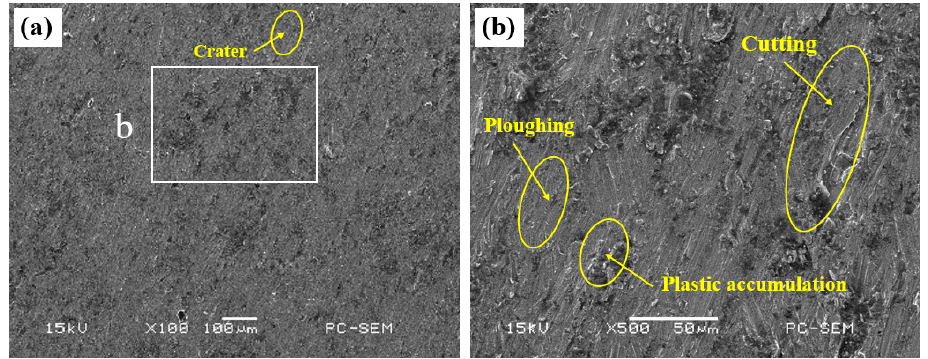
Figure 4. ( a ) SEM morphologies on worn surface I at 100 magnification, ( b ) Enlarged view of area b in ( a ) at 500 magnification.